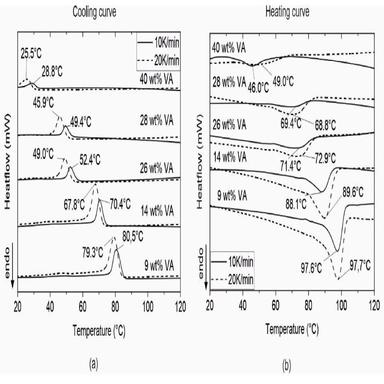
DSC thermograms of the reference EVA grades; (a) first cooling and (b) second heating cycle for different heating/cooling rates of 10 and 20k/min, respectively.